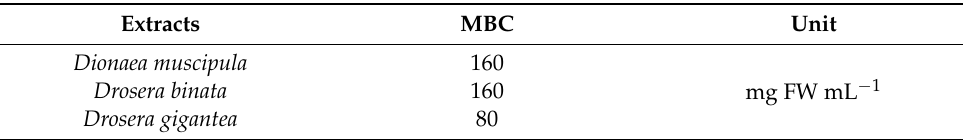
Table 1. Comparison of antimicrobial potential of carnivorous plant extracts.